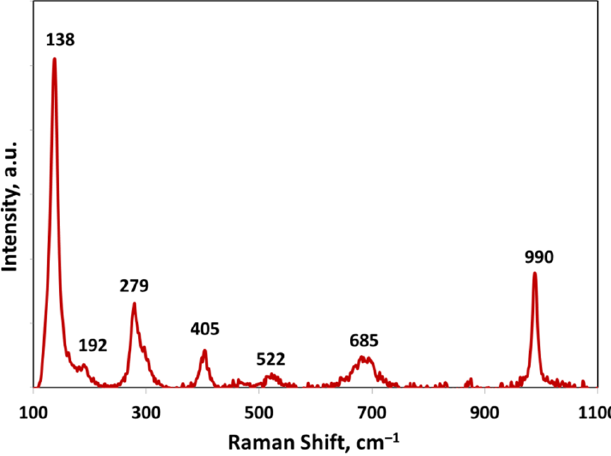
Figure 9. Raman spectra of V 2 O 5 used.